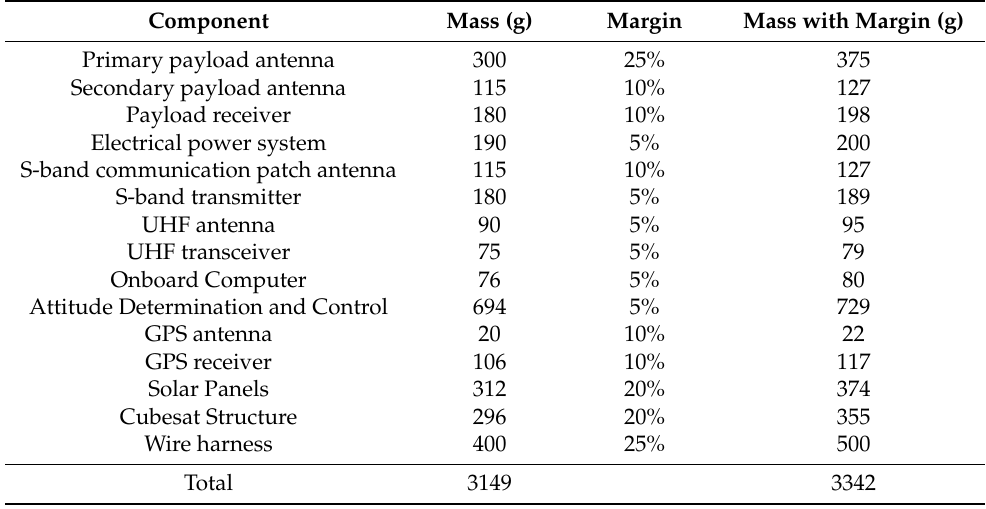
Table 5. Mass budget for